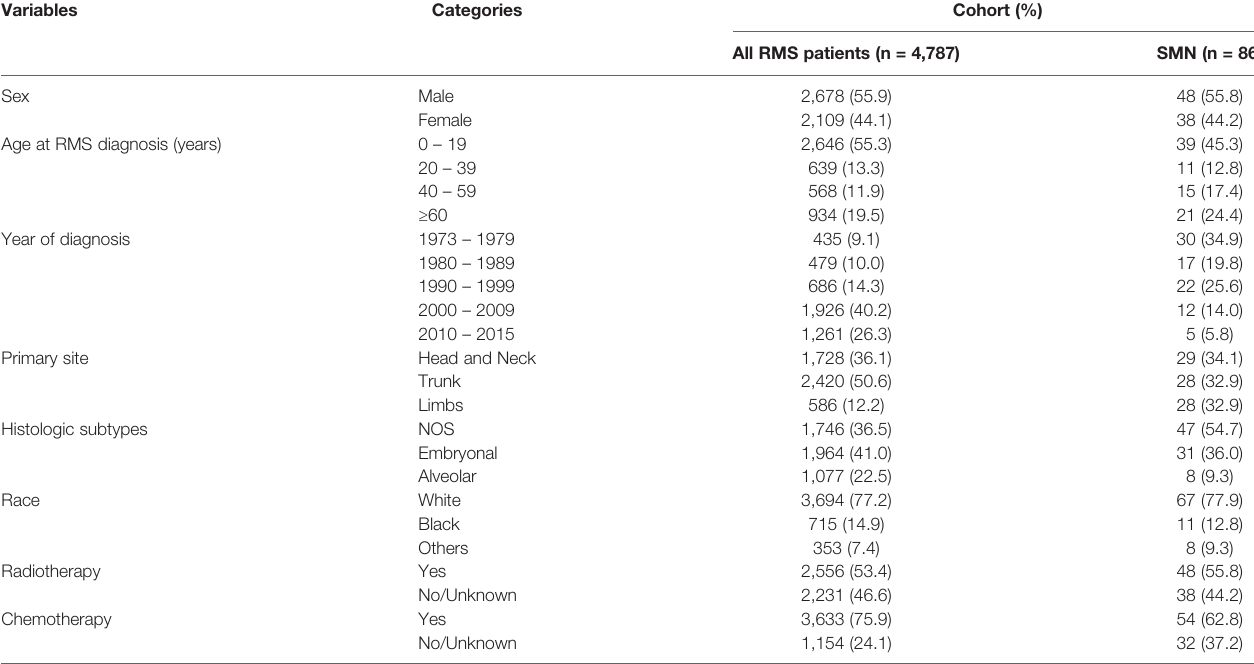
TABLE 1 | Demographic and clinical characteristics of patients with